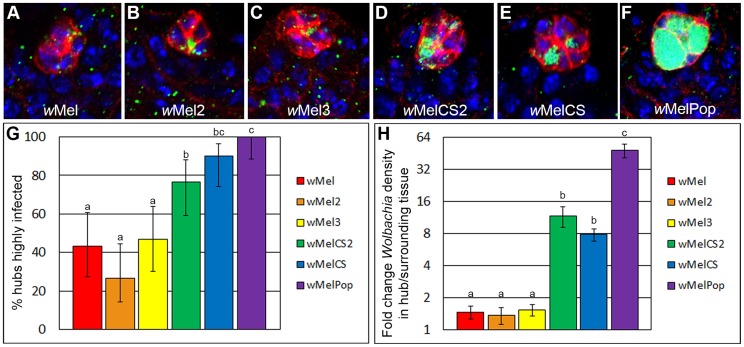
Closely related Wolbachia strains display rapidly divergent hub tropism phenotypes in Drosophila melanogaster.(A-F) Representative images of wMel-like strains: wMel, wMel2, wMel3; and wMelCS-like strains: wMelCS2, wMelCS and wMelPop infecting D. melanogaster hubs [Wolbachia, green; hub marker, red; DNA, blue]. (G) Quantification of frequency of hub tropism. The three wMel-like Wolbachia strains target the hub at similar frequencies, significantly different from the wMelCS-like strains. Frequencies with different letters are significantly different (two-sample test for proportions, error bars represent 95% confidence intervals). (H) Quantification of density of Wolbachia infecting the hub. The three wMel-like Wolbachia strains target the hub at similar densities, and are significantly different from the wMelCS-like strains. Means with different letters are significantly different from one another as determined by a t-test, error bars represent SEM.